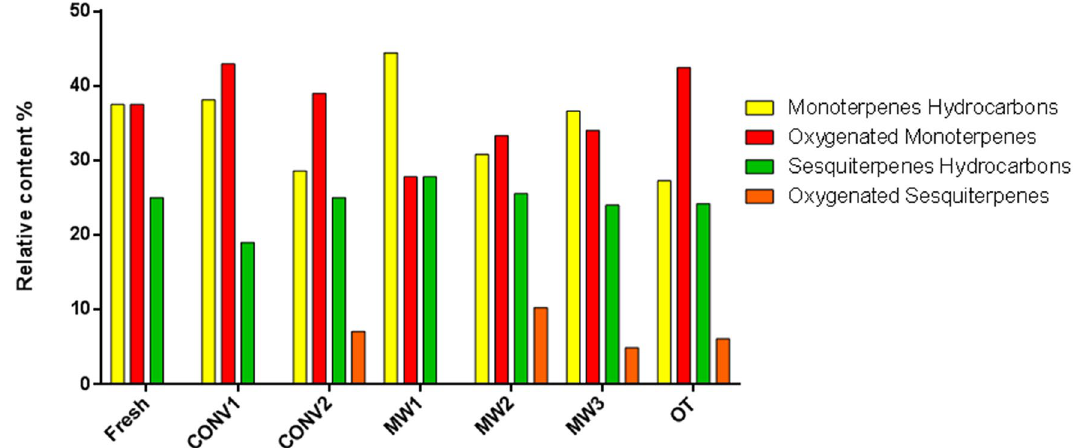
Figure 3. Percent composition of main chemical groups in the essential oils subjected to different treatments.